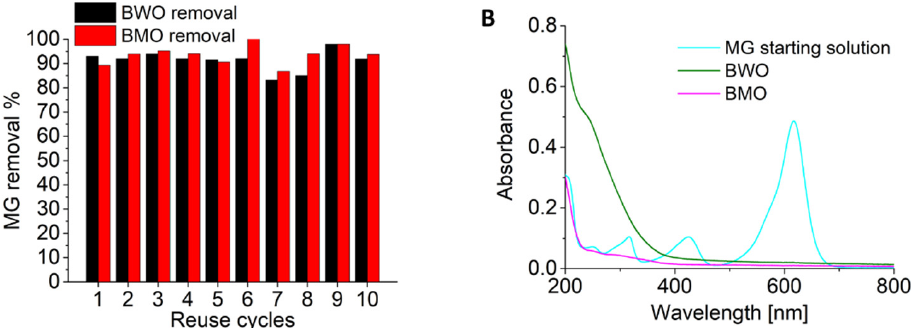
Figure 6. ( A ) Reuse cycles of BWO and BMO photocatalysts; ( B ) UV-Vis spectra of MG solution before and after 10 cycles in contact with the photocatalyst.